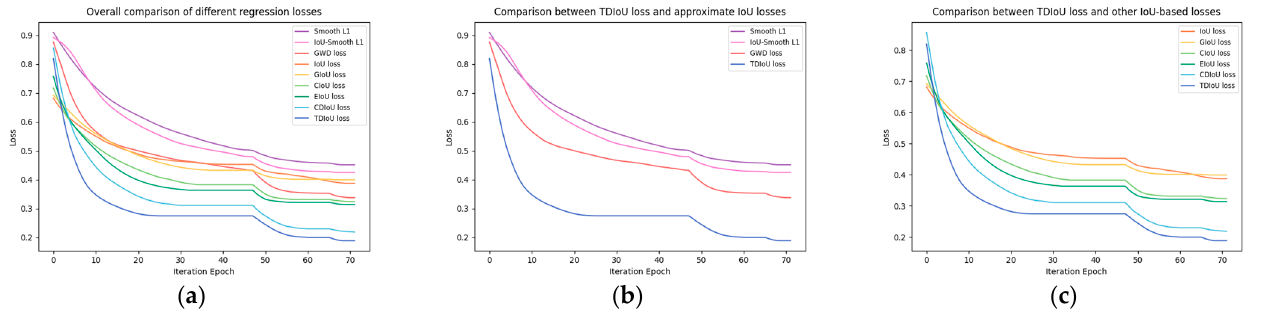
Figure 21. Regression loss curves of RetinaNet-R on RSSD. ( a ) Overall comparison of different regression losses; ( b ) comparison between TDIoU loss and approximate IoU losses; ( c ) comparison between TDIoU loss and other IoU-based losses.